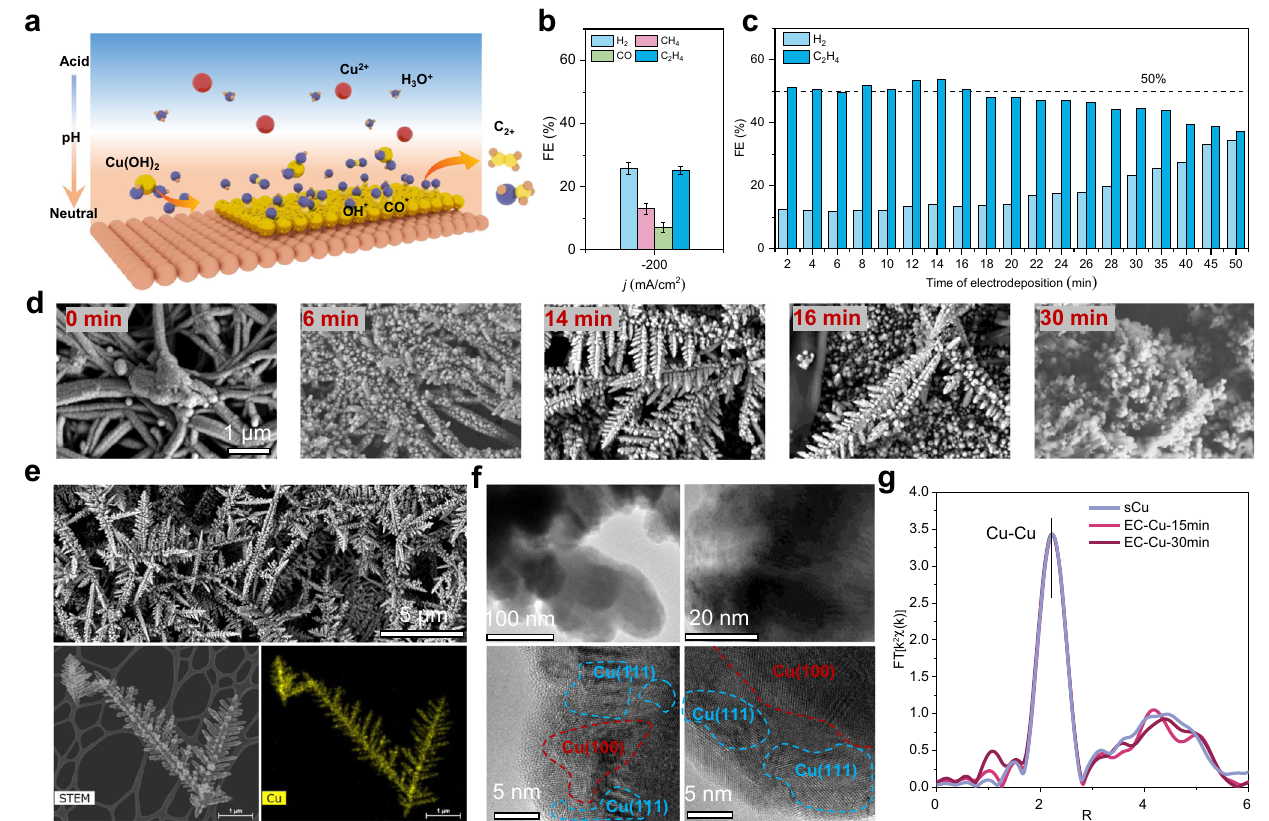
Fig. 2 | In situ electrodeposition in acidic CO2R. a Schematic of Cu(OH) x medi- atedinsituelectrodepositionduringacidicCO 2 Rina fl owcell. b Gas-phaseproduct distribution of sCu in acidic CO 2 R. The error bars correspond to the standard deviation of three independent measurements. c FE H2 and FE C2H4 ofin situ formed EC – Cu at different time of electrodeposition. The CO 2 R was performed at 200mAcm − 2 in 0.05M H 2 SO 4 and 2.5M KCl containing the copper precursor (5mM). The FE of CO and CH 4 were less than 1% and not listed. d